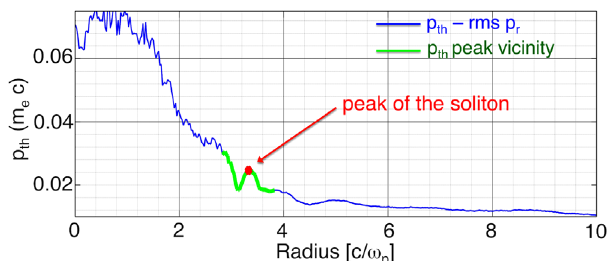
FIG. 5. Radial profile of the root-mean-square radial electron momentum (proportional to the square root ffiffiffiffiffi p T of the electron temperature, for the beam- ) at 460 ω − 1 e pe ð r Þ ¼ radial electron momentum, p e ffiffiffiffiffiffiffiffiffiffiffiffiffiffiffiffiffiffiffiffiffiffiffiffiffiffiffiffiffiffiffiffiffiffiffiffiffiffiffiffiffiffiffiffiffiffiffiffiffiffiffiffiffiffiffiffiffiffiffiffiffiffiffiffiffiffiffiffiffiffiffiffiffiffi p th ½ Σ ð k; r Þ 2 π rn ð k; r Þ(cid:2) = Σ 2 π rn ð k; r Þ p 2 profile of the wake k e k e r electrons corresponding to the time in Fig. 2 at 460 ω − 1 . This ffiffiffiffiffi p pe ∝ T represents the square root of the electron temperature, p e . e th T The radial gradient of the temperature, ∂ is thus computed at ∂ r e the peak of the soliton (red) and in its vicinity (green). It is ð 1 Þ j ¼ 0 T interesting to note that ∂ e ∂ r peak